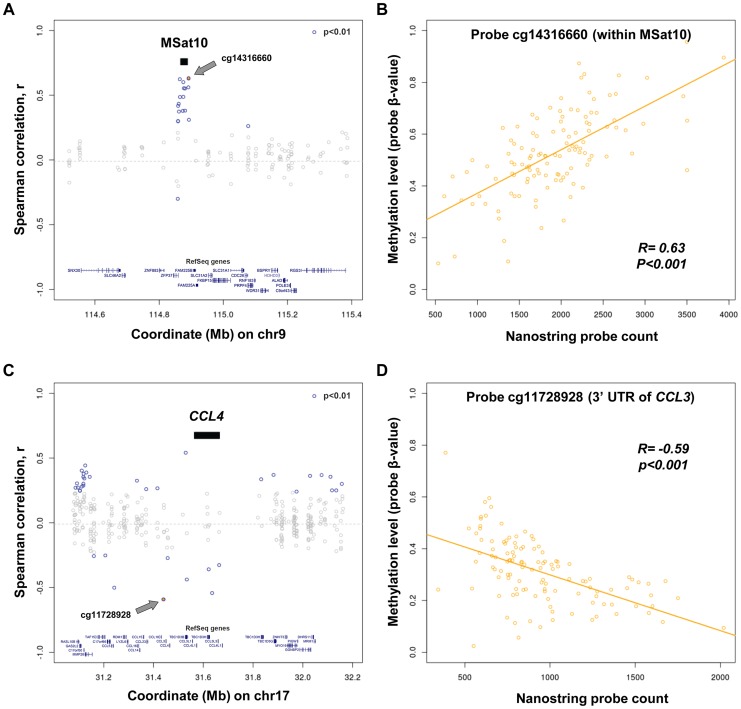
Variation in copy number of tandem repeats and multicopy genes is associated with alterations of local DNA methylation.(a and c) Shown are correlation values between copy number of (a) MSat10 and (c) CCL4 with all methylation probes within ±500 kb in 118 CEU and YRI HapMap individuals. (b and d) Scatter plots showing individual level data for the methylation probes showing the strongest correlations with copy number of Msat10 and CCL4. (b) Increasing copy number of MSat10 is associated with increased methylation levels of cg14316660, (R = 0.63, permutation p<0.001). This association was replicated using a Sequenom assay targeted to the MSat10 locus (Figure 5c), confirming that it is not simply due to a technical artifact related to CNV of the underlying probe binding sites. (d) Increasing copy number of CCL4 is associated with reduced methylation levels of cg11728928 (R = −0.59, permutation p<0.001). In (a) and (c), black bars indicate the interval to which each Nanostring probe maps, CpGs showing correlation p<0.01 are indicated in blue, while the CpG showing the strongest correlation is shown as a filled blue circle and labeled with a grey arrow (with individual data plotted in (b) and (d), respectively).